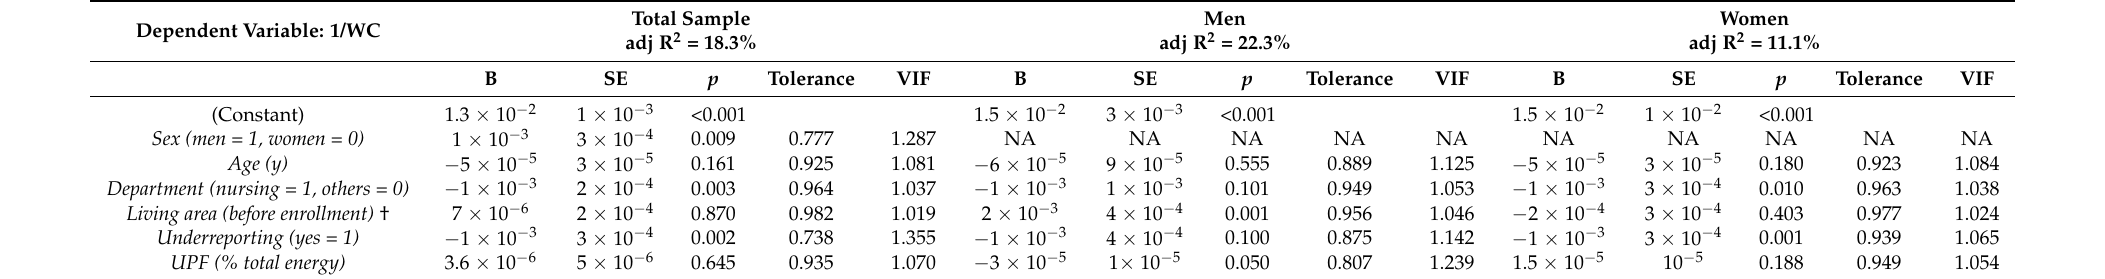
Table 3. Linear regression analysis for l/WC in the total sample, men and women.